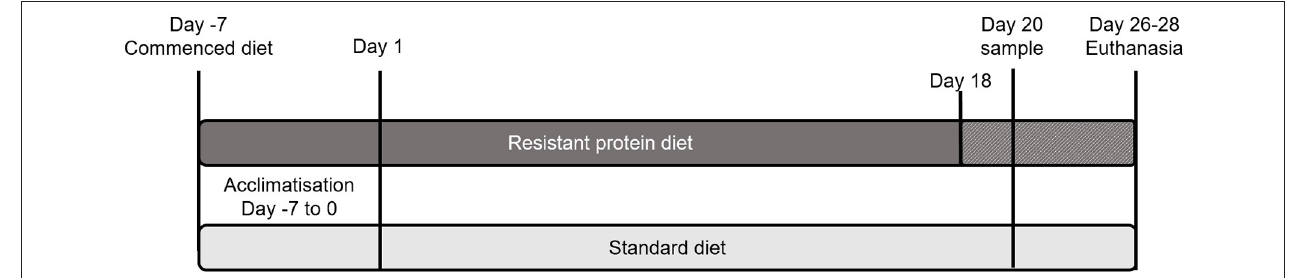
FIGURE 1 | Schematic of the study design showing the period of acclimatisation and the schedule of standard and resistant protein diets, including supplementation of resistant protein with the standard diet from Day 18 and sampling on day 20.